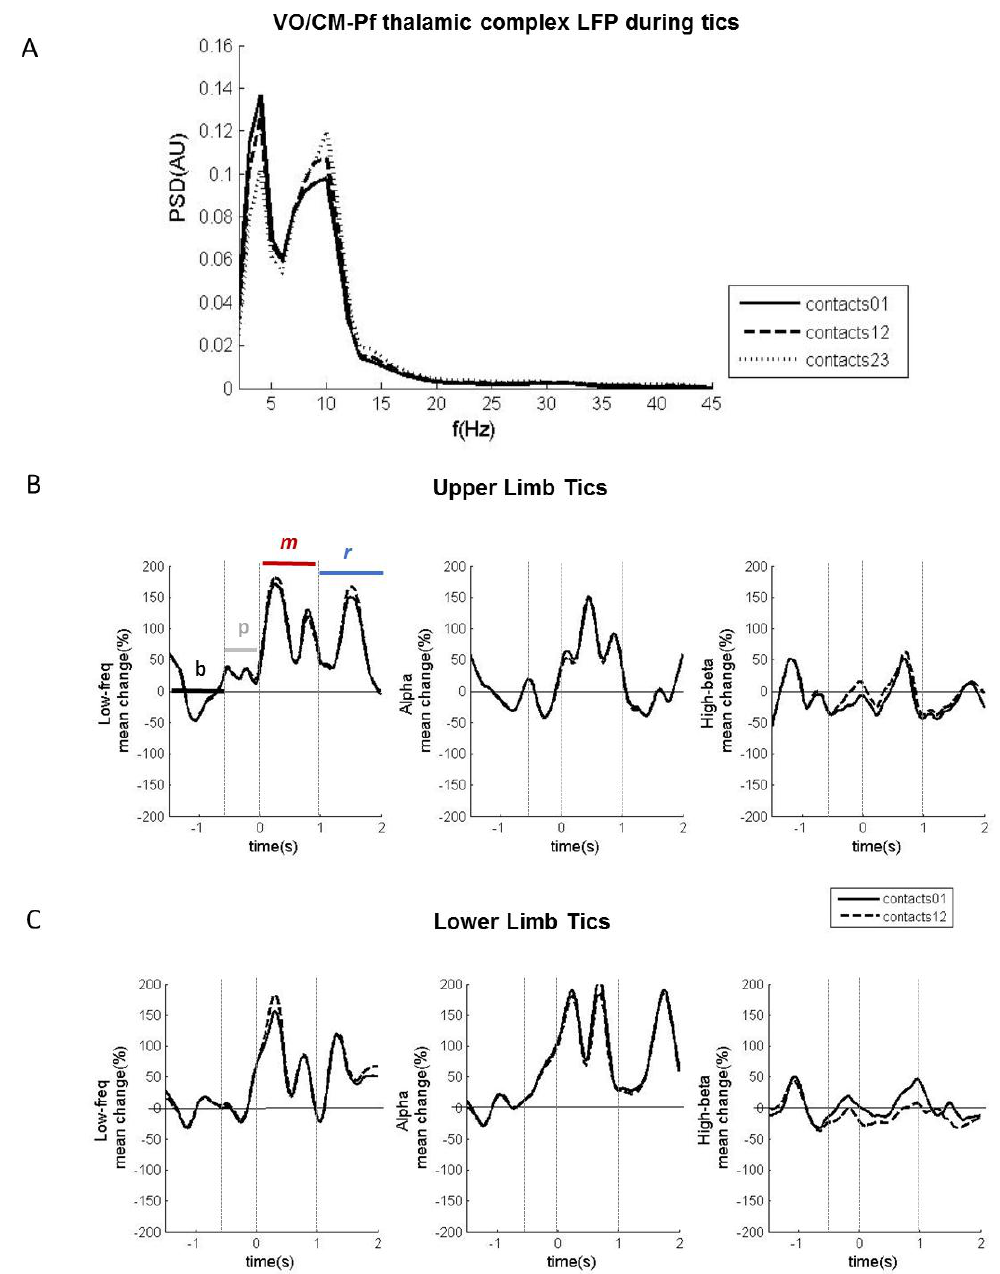
Figure 3. Vo/CM-Pf LFP oscillations during involuntary movements in one patient. ( A ) Power spectrum of LFPs captured from the Vo/CM-Pf nucleus using contacts 0–1 (black solid line), 12 (dashed black line), and 23 (dashed grey line) during motor tics. The x -axis represents frequency (Hz) and the y -axis represents the normalized power spectral density (PSD, arbitrary unit). ( B ) LFP power modulations for the low-frequency, alpha, and high beta bands recorded during upper limb tics from the electrode contact pairs 0–1 and 1–2, averaged across all observed tics. Power modulations are expressed as percentage changes from the baseline phase and were estimated starting 1.5 s before the movement onset until 2 s after the movement onset. The four movement-related phases were baseline (b), pre-movement (p), movement (m), and recovery (r). X -axis: time (s); y -axis: Hilbert-power modulations (%). ( C ) LFP power modulations for the low-frequency, alpha, and high beta bands recorded during lower limb tics from electrode contact pairs 0–1 and 1–2, averaged across all observed tics. The plots are organised as they are in panel